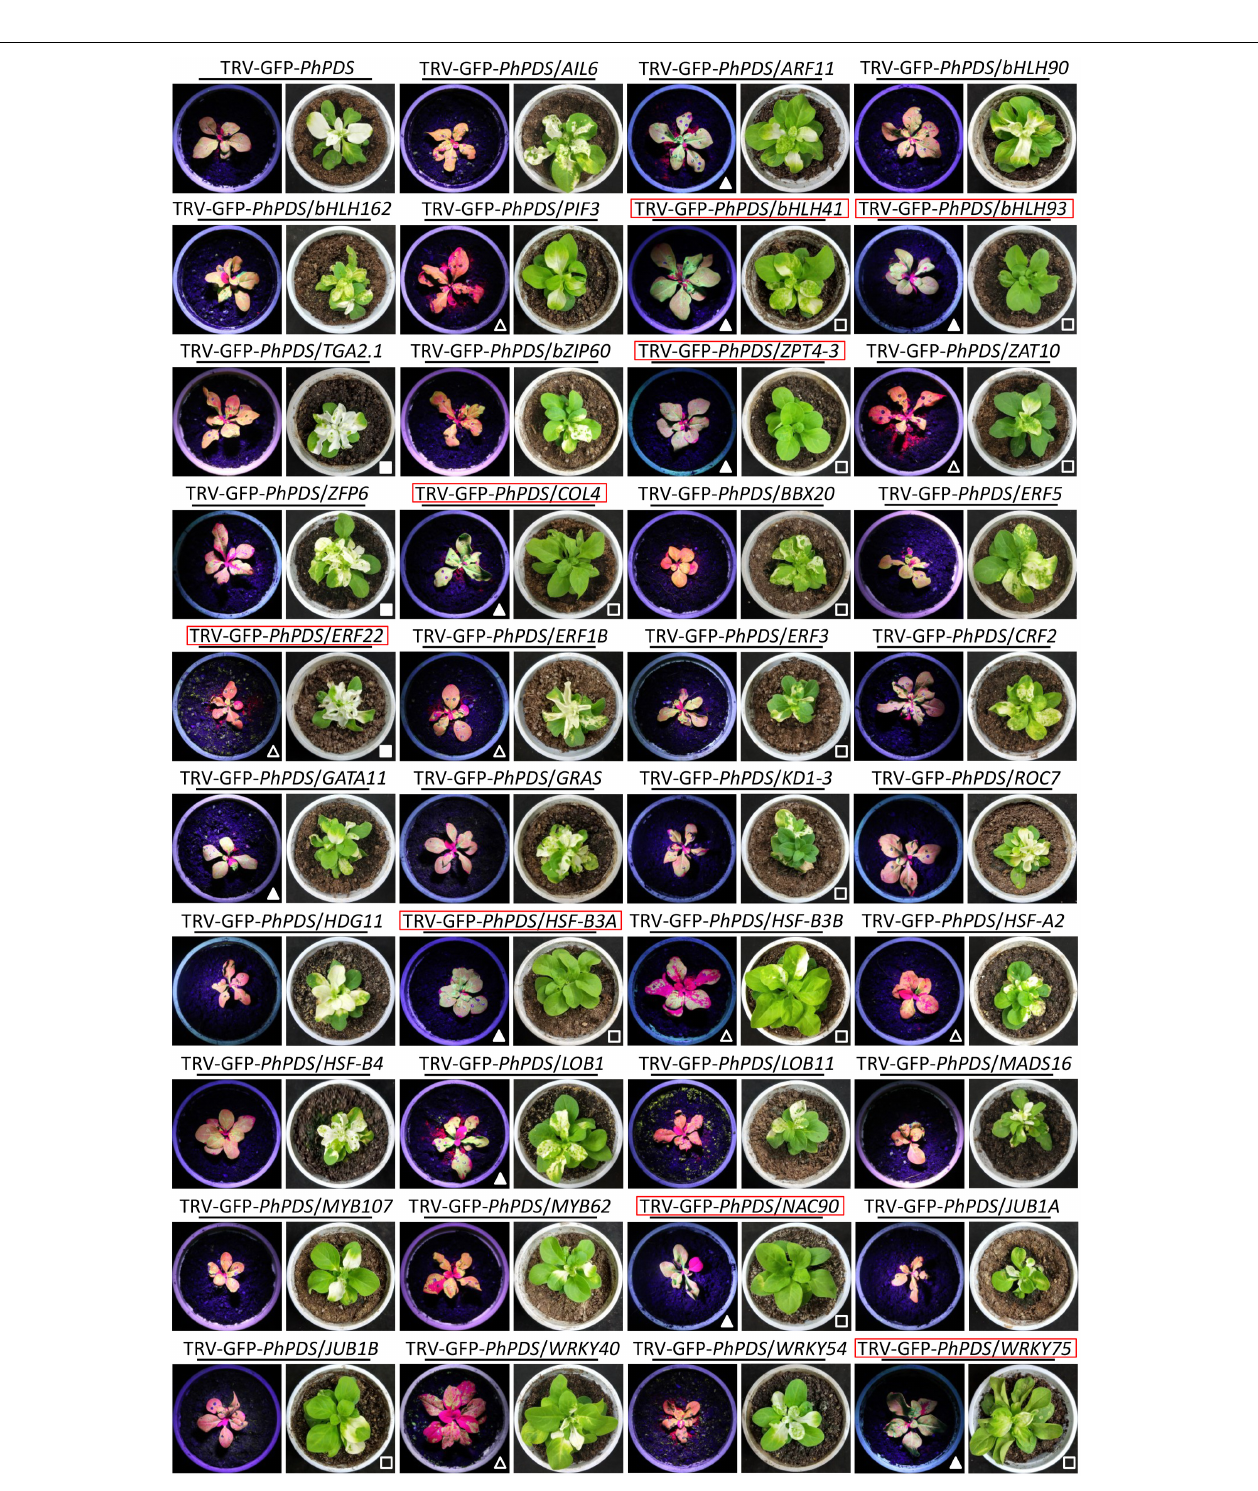
FIGURE 6 | Development of GFP fluorescence and photobleaching phenotype in petunia leaves with VIGS silencing of various transcription factors. Representative GFP-expressed fluorescence signals and PhPDS -silenced photobleaching phenotypes in petunia leaves inoculated with Agrobacterium containing 39 transcription factors (TFs)-inserted TRV-GFP- PhPDS constructs. Three-week-old seedlings of petunia were used for the agro-inoculation. Photographs were taken at 4 and 14 days post inoculation for fluorescence and photobleaching phenotypes. The TRV-GFP- PhPDS construct containing no TF insert was used as the control. In comparison with the control, enhanced and suppressed GFP fluorescence signals are highlighted by solid and hollow triangles, while improved and impaired leaf photobleaching phenotypes are denoted by corresponding squares, respectively. The predicted TFs regulating antiviral RNA silencing are marked by red squares.